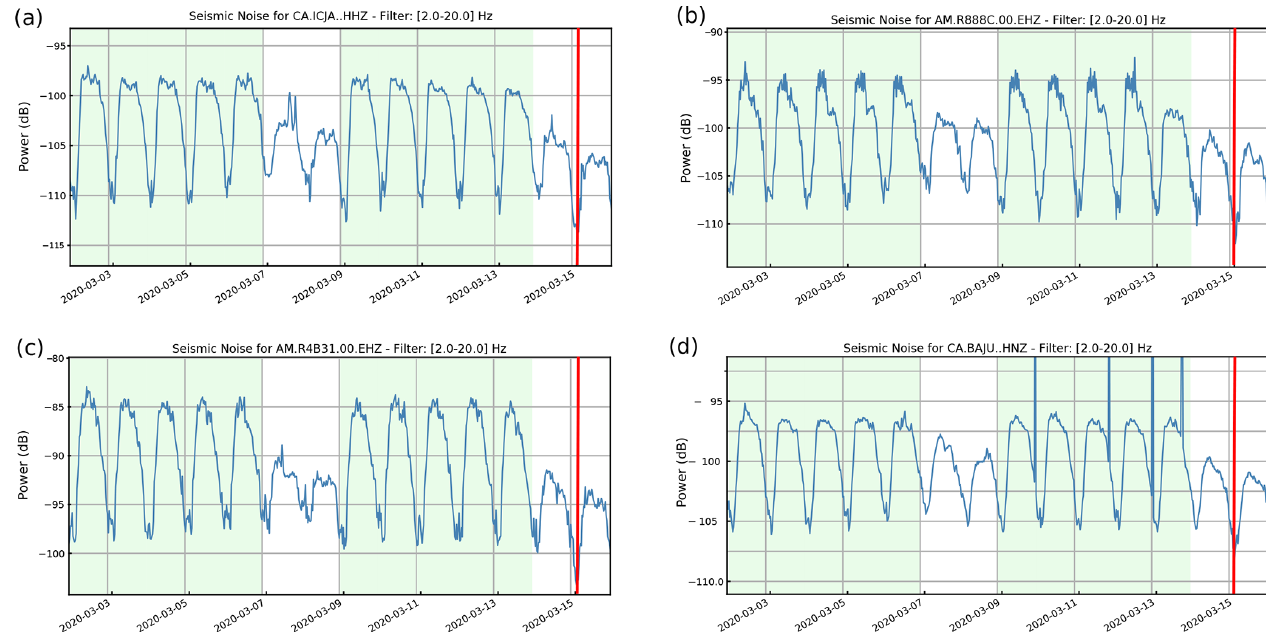
Figure 3. Trends in power acceleration variation in the 2–20Hz band prior to lockdown at the ICJA (broadband), R888C, R4B31 (short- period stations installed in high schools) and BAJU (accelerometer located downtown). Data are expressed as dB relative to 1m 2 s − 4 Hz − 1 . Red line marks the beginning of the lockdown period. Green shading indicates weekdays.